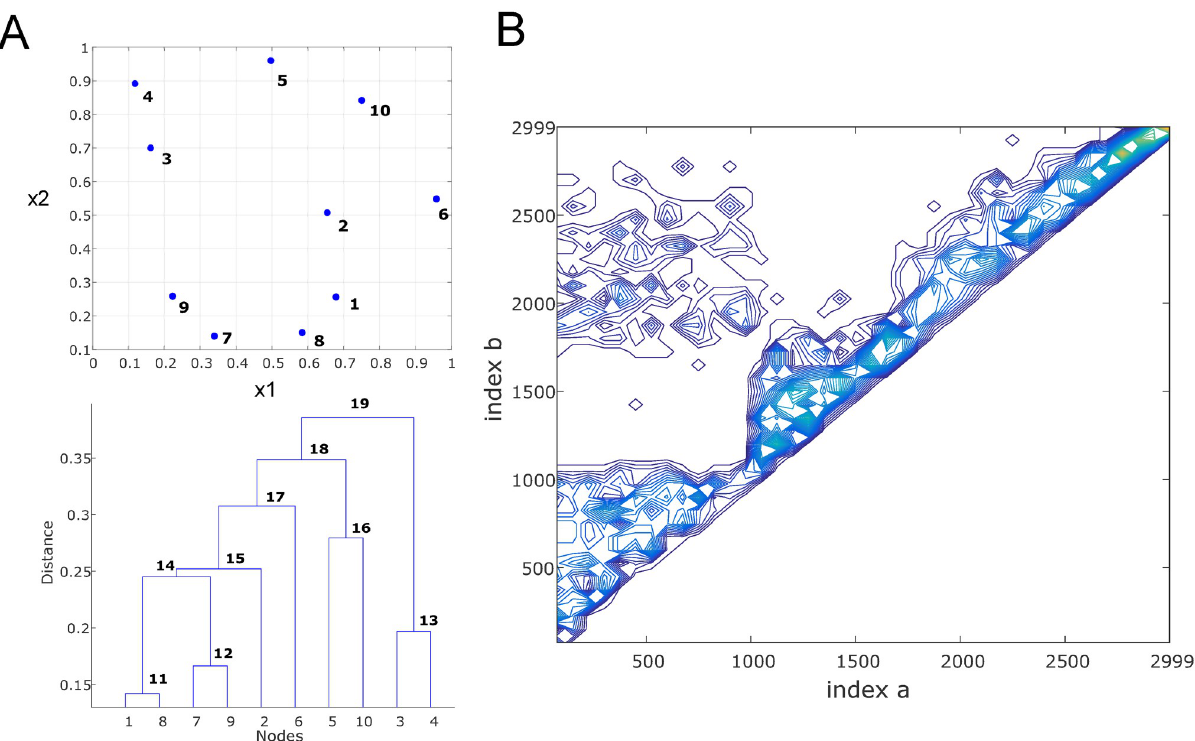
Fig 1. Illustration of linkage analysis. (A) Example of M = 10 data points randomly placed on 2-dimensional coordinate plane (x1, x2), and resultant linkage analysis using single link distance function with Euclidean (L2 norm) distance metric. The leaf nodes of the dendrogram (lower plot), numbered 1 to 10, represent the original data points, and the branch nodes, numbered from M + 1 to 2 M – 1 represent the pairwise linkages based on separation hierarchy. (B) Contour plot of 2-dimensional histogram of linkage coordinate indices ( a , b ) corresponding to the linkage hierarchy for a randomly generated pair of clusters formed from M = 1500 data points (500 for cluster #1 and 1000 for cluster #2). Due to index condition b > a , the values below the diagonal are zero.